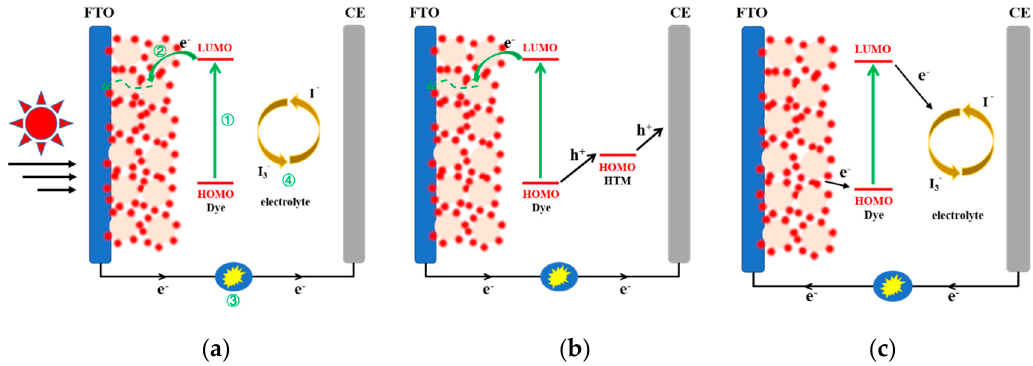
Figure 1. Schematic diagram of charge transport mechanisms in ( a ) liquid n-type DSSCs; ( b ) solid- state n-type DSSCs); ( c ) liquid p-type